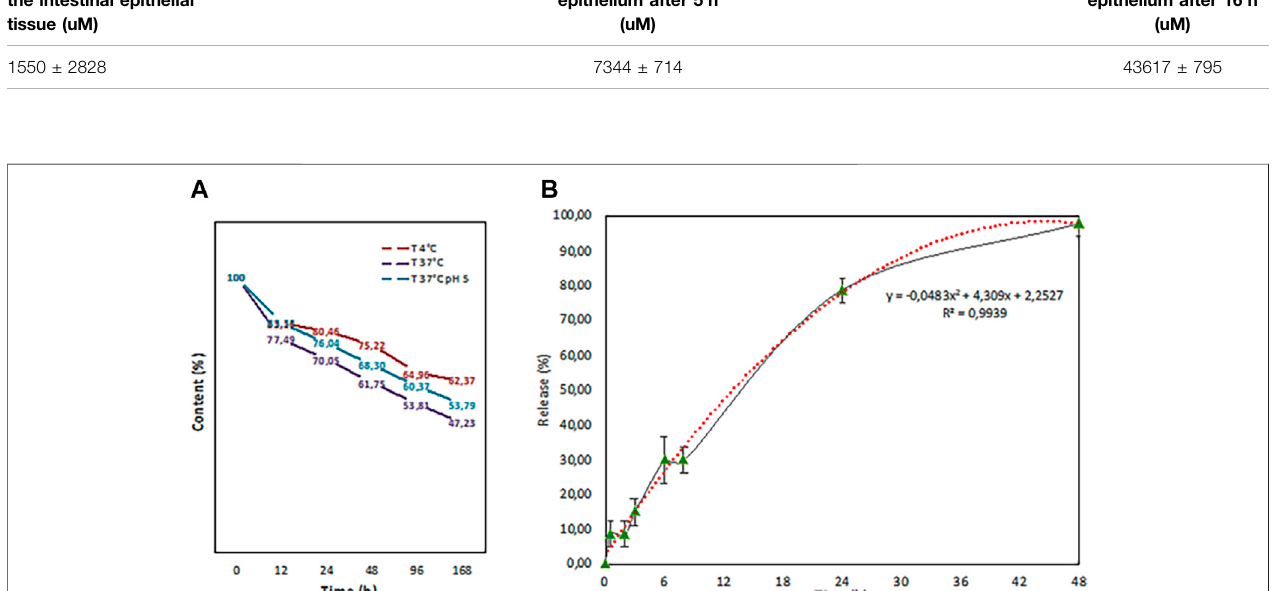
TABLE 3 | Quanti fi cation of fi setin concentration after incubation with the intestinal epithelium for 5 or 16 h. Concentration of PLGA (Fis) added to the intestinal epithelial tissue (uM)